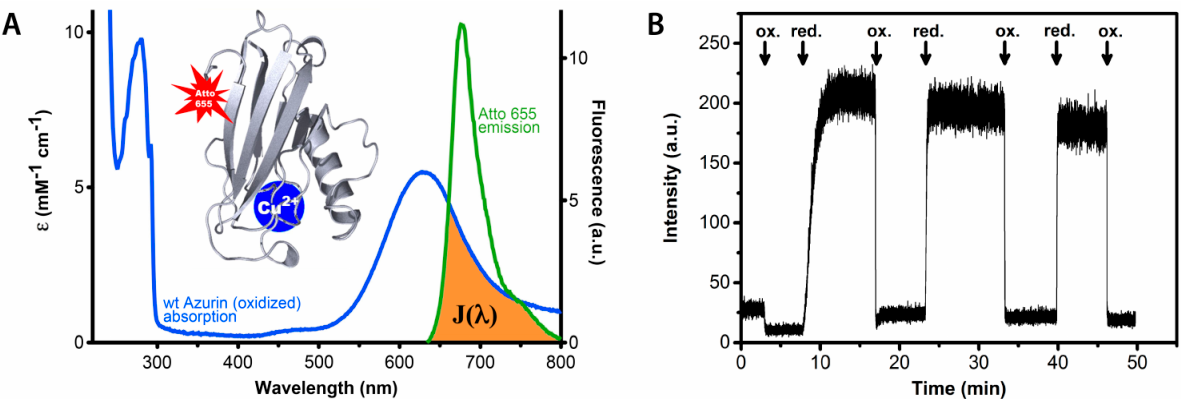
Figure 2. Cartoon representation depicting the overall structure (top) and active site (bottom) of nitrite reductase from Alcaligenes xylosoxidans ( A ) (pdb: 1oe1) and small laccase from Streptomyces coelicolor ( B ) (pdb: 3cg8). A